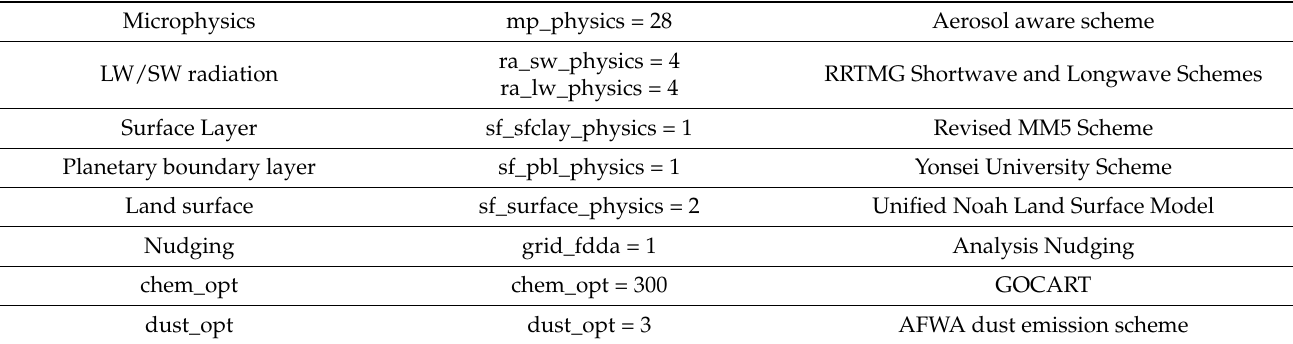
Table 1. Physical and chemical options and the namelist